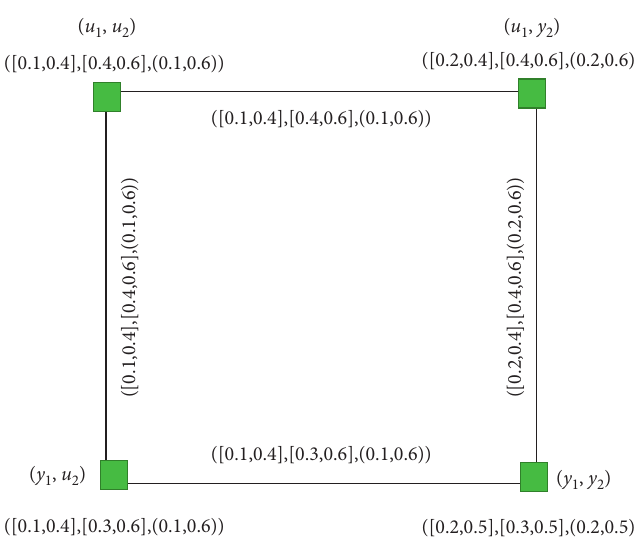
Figure 12: Cartesian product of cubic intuitionistic fuzzy